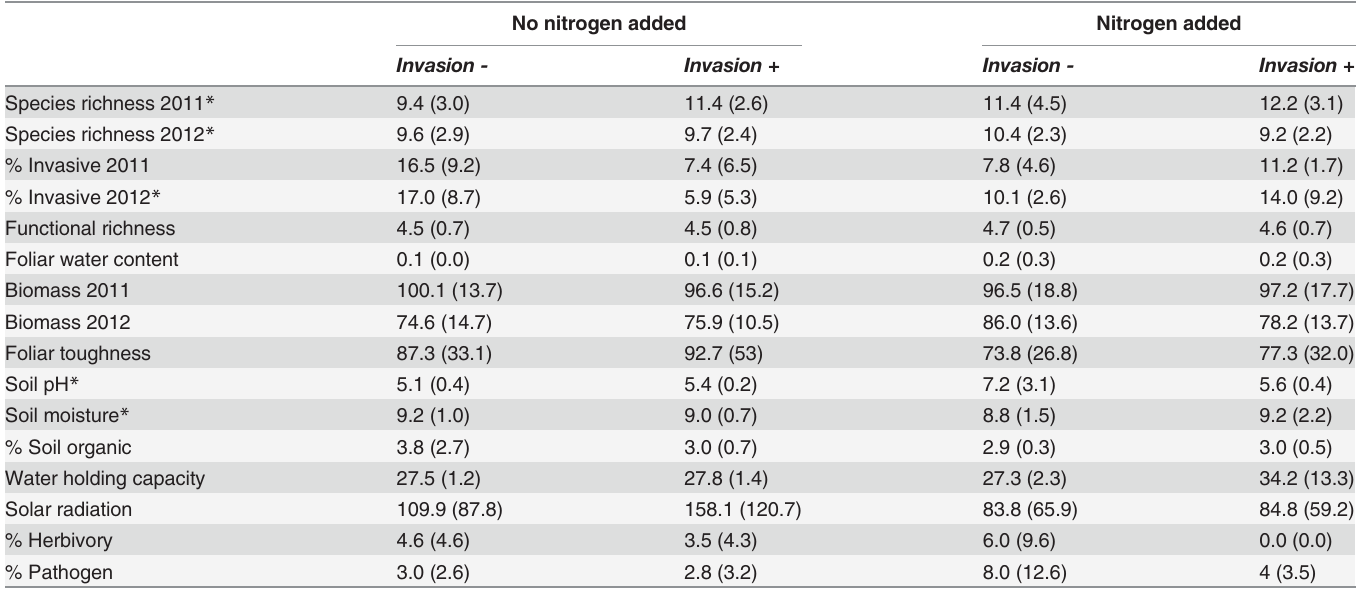
Table 1. Means and (SD) for environmental factors from plots exposed to the nitrogen treatment (data from warming treatment plots excluded).